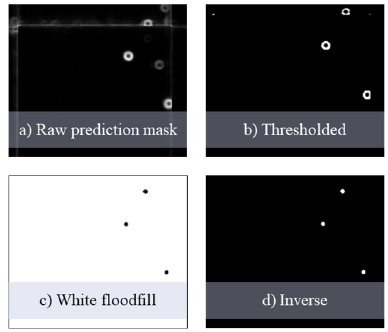
Figure 7. Image pre-processing to optimise the prediction result mask prior to the line fitting